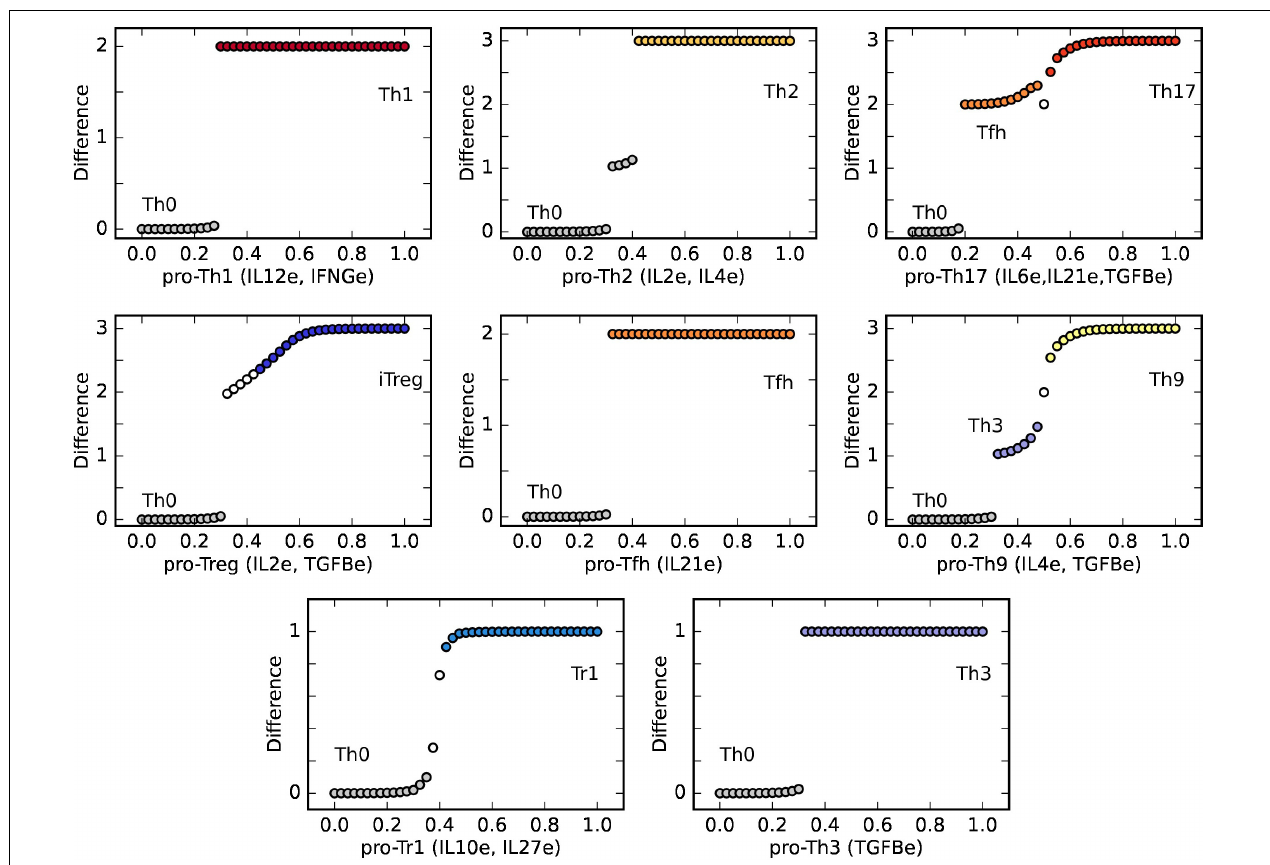
FIGURE 4 | T-CD4 cell fate as a function of exogenous cytokine concentrations define diverse phenotype-associated environments. From the Th0 initial state, a CD4+ T cell evolves to different phenotypes, depending on critical concentrations of environmental cytokines as shown in Table 1 : Th1 (IFNG and IL12), Th2 (IL4, Il2), Th17 (Il21, TGFB), Treg (IL2, TGFB), Tfh (IL21), Th9 (IL4, TGFB), Tr1 (IL10, IL27), and Th3 (TGFB). The plot shows the difference between the values of the initial Th0 state and the final steady state at different concentrations of exogenous cytokines. The transition may be abrupt or gradual and, interestingly, may involve